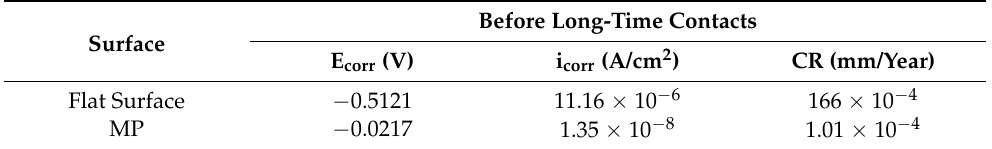
Table 2. Corrosion potential (E corr ), corrosion current density (i corr ), and corrosion rate (CR) of the flat surface [1] and micropillar surface (MP) before long-time contacts with NaCl solution.